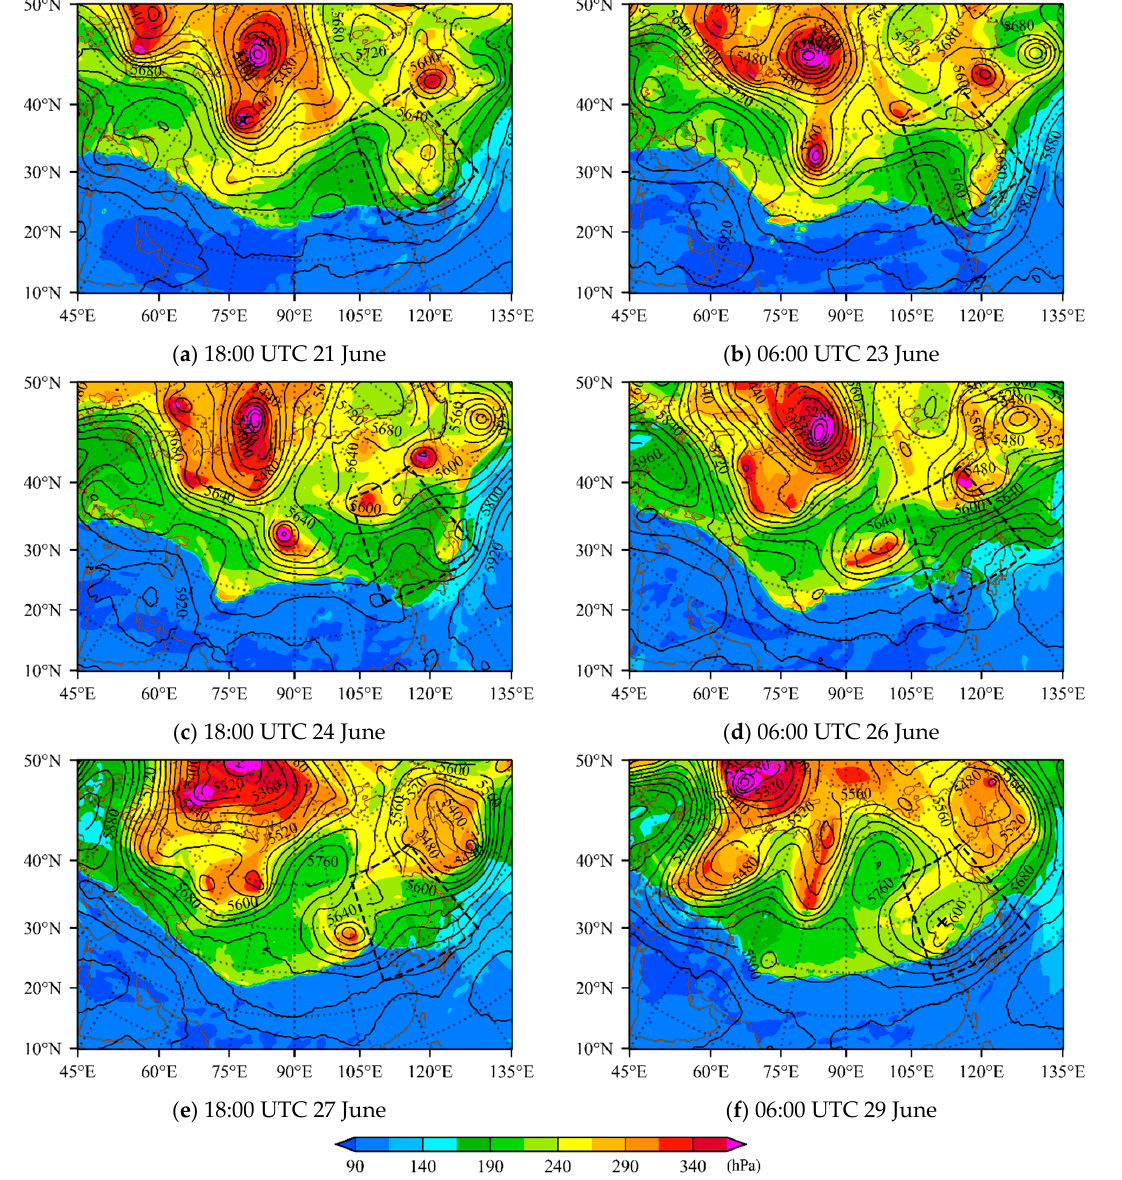
Figure 8. Spatial distributions of tropopause pressure (color shaded, unit: hPa) and geopotential height at 500 hPa (contours, interval: 40 gpm) of ERA5 reanalysis from 21 to 29 June 2019. The black crosses in ( a , f ) indicate the NCCV centers determined by low geopotential height center at 500 hPa. Tropopause pressure is calculated with temperature from ERA5 reanalysis.